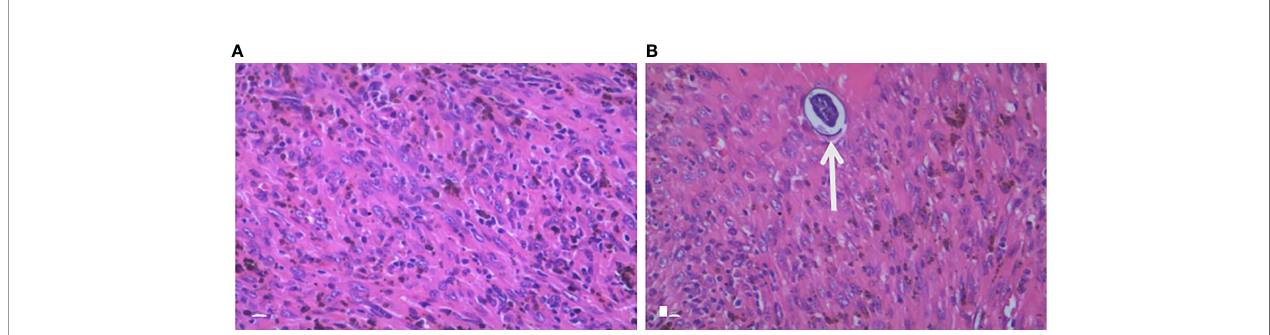
FIGURE 3 | Pathological examination. Histology with H&E staining of the excised pancreatic tumor mass shows large pleomorphic, spindle-shaped cells, fi brosis, which indicate a stromal malignancy (A) . Another slide of the tumor shows schistosome in the tumor tissue ( B , arrow).